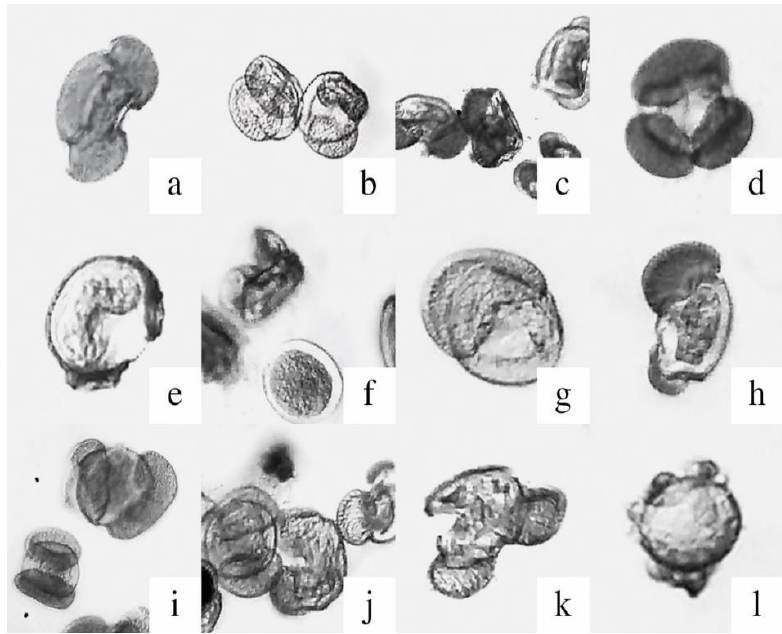
Figure 1. Pollen grains of Pinus sylvestris L. in Murmansk: ( a ) — normal, ( b ) — without protoplast (sterile), ( c ) — with plasmolysed protoplast, ( d ) — hypertrophied with three sacci, ( e ) — with reduced sacci, ( f ) — without sacci, ( g ) — with a single saccus, ( h ) — two dissimilar sacci, ( i ) — giant, ( j ) — dwarf, ( k ) — with exine rupture, ( l ) — dwarf with outgrowths. (Vasilevskaya, Domakhina, 2016 [63]). According to the palynological scale of ecological zoning of territories by N. A. Kal-